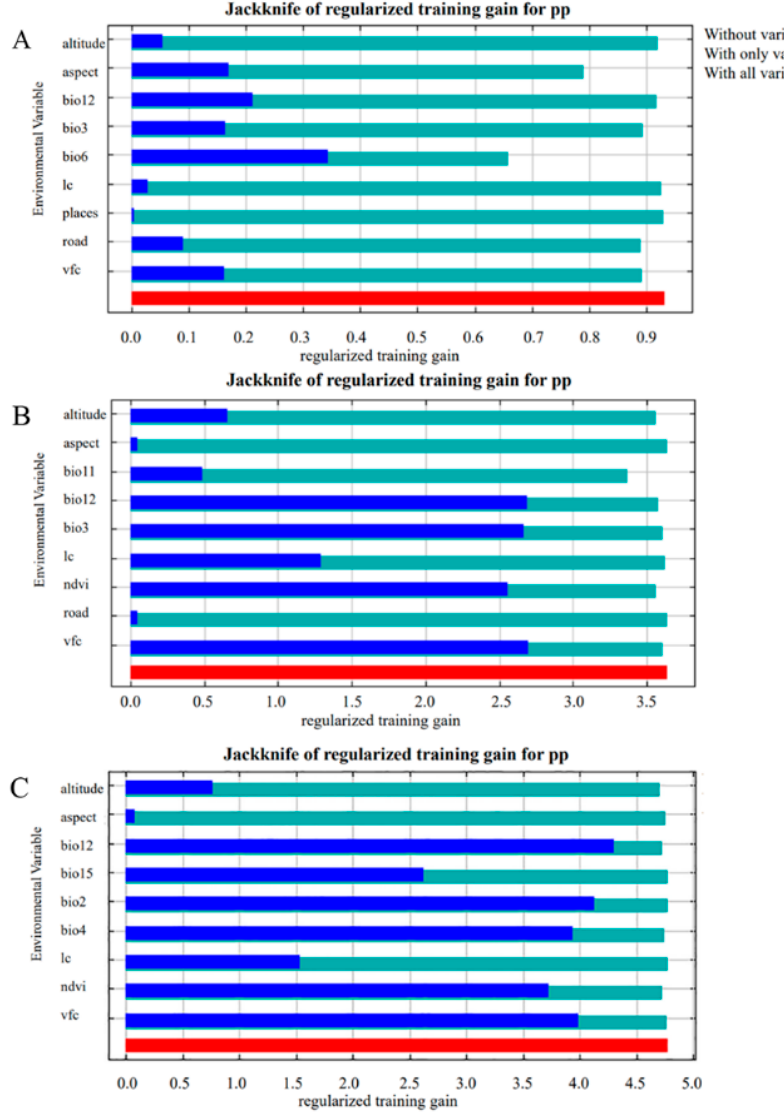
Figure 6. Jackknife method testing the importance of the influence of different geographic scales and main environmental variables on the distribution of suitable leopard habitat. ( A ). The Liupanshan scale environmental variable knife cutting method test. ( B ). The Guyuan city scale environmental variable knife cutting method test. ( C ). The Ningxia city scale environmental variable knife cutting method test.